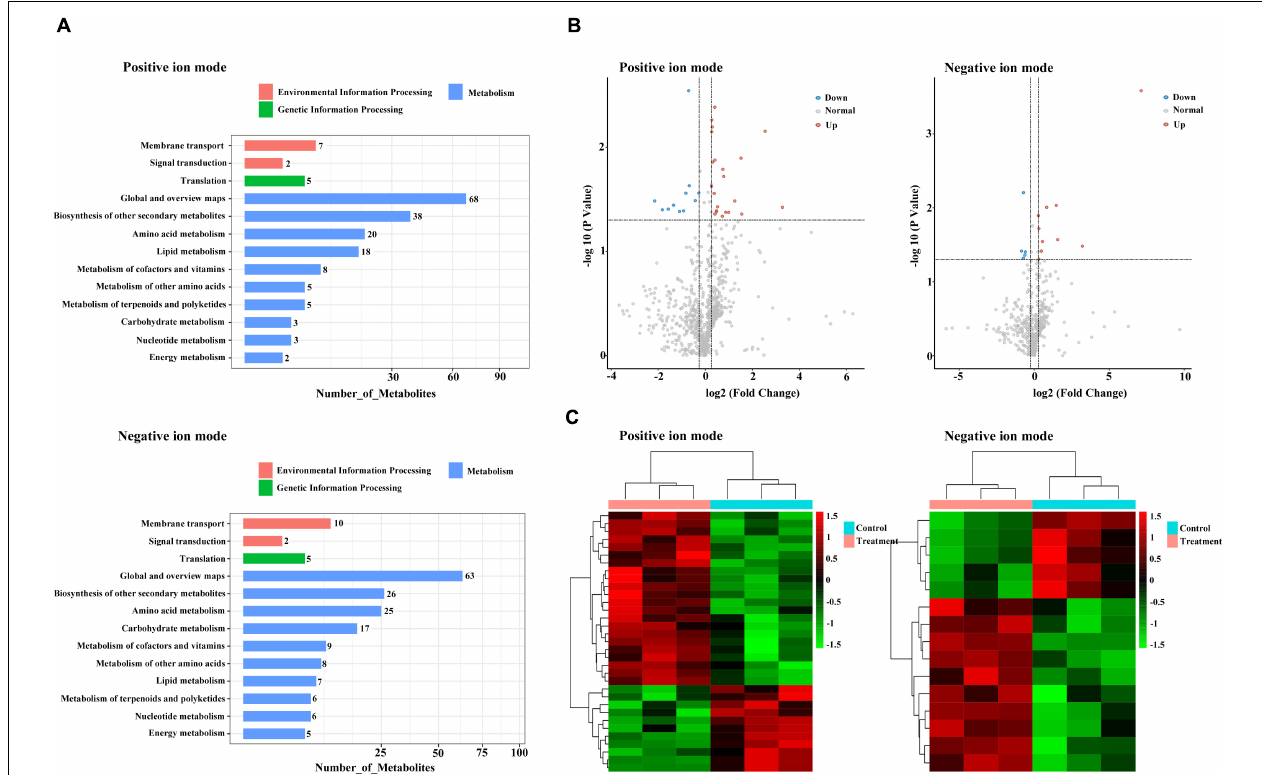
FIGURE 8 | Metabolomic profiles of the treated and control groups. (A) KEGG pathways of all annotated metabolites. (B) Volcano plot of differentially accumulated metabolites. (C) Heatmap of differentially accumulated